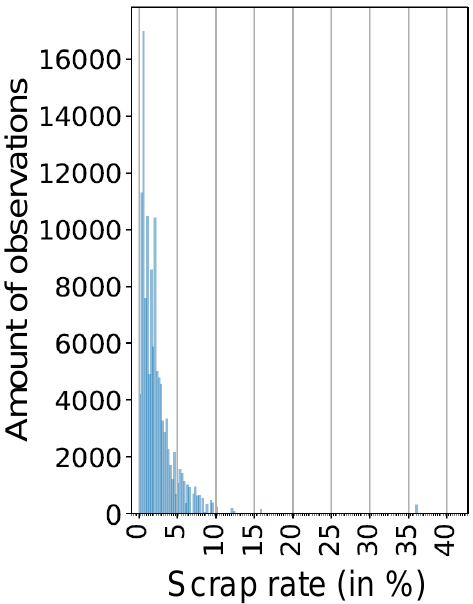
Figure 6. Scrap rate histogram for an exemplary